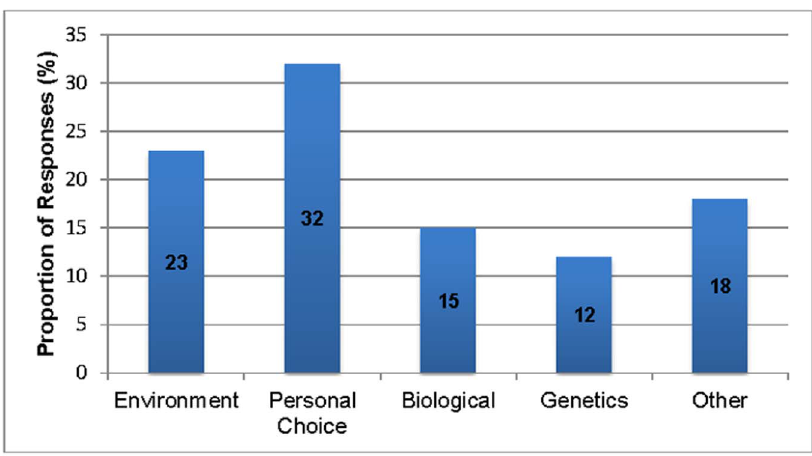
Figure 1. Responses as to the main cause of obesity.